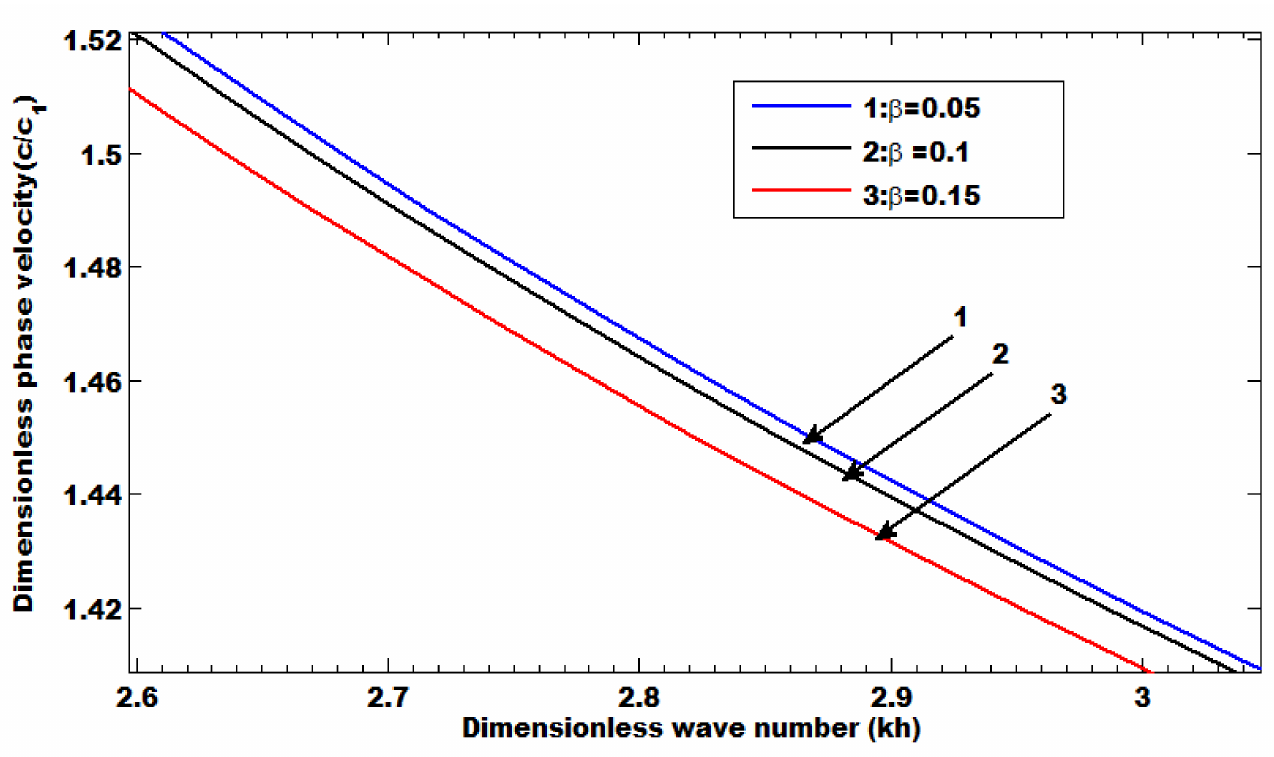
Figure 2. The phase velocity with wave number when a 1 = 0.1, p = 0.01, a 2 = 0.2, m = 0.08, h = 0.04, α =